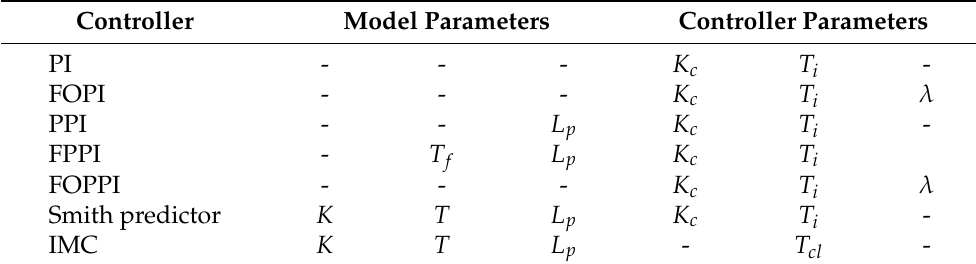
Figure 8. IAE values of various controllers in WirelessHART network [14]. Table 6. Tunable parameters of various controllers [70].